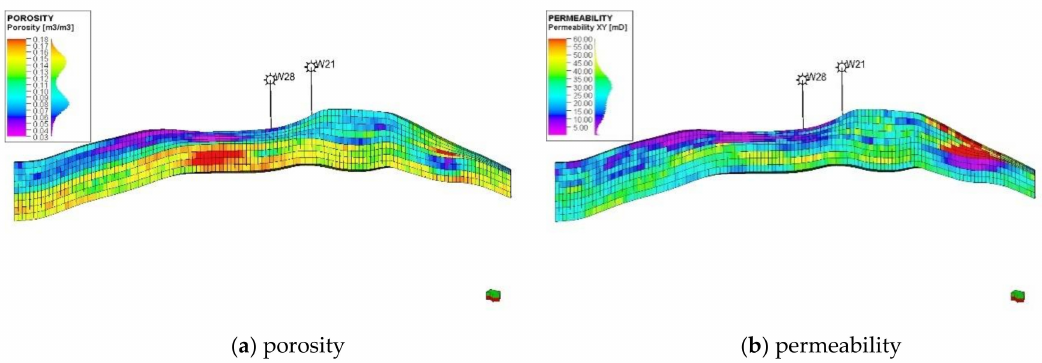
Figure 2. Geological parameter distributions along the vertical cross section